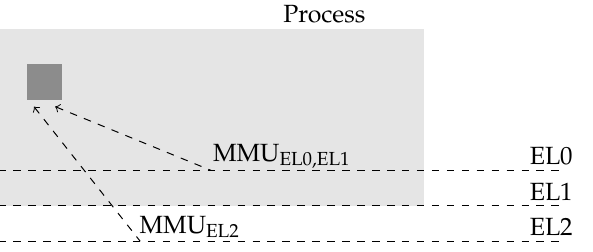
Figure 9. Asymmetric dual view. Two exception levels access the same physical frame with the same virtual address of some process. However, the page tables of the two exception levels are not